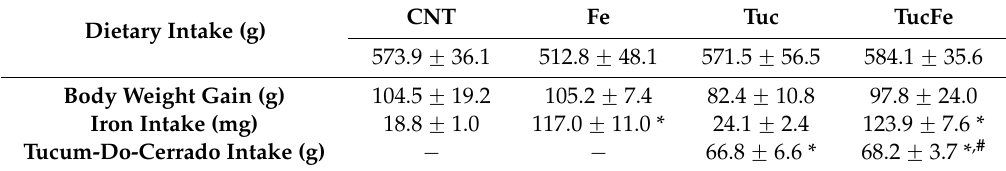
Table 1. Effects of tucum-do-cerrado ( Bactris setosa Mart.) consumption on dietary intake and the body weight gain of rats treated with AIN-93G diet supplemented or not supplemented with iron for 30 days.